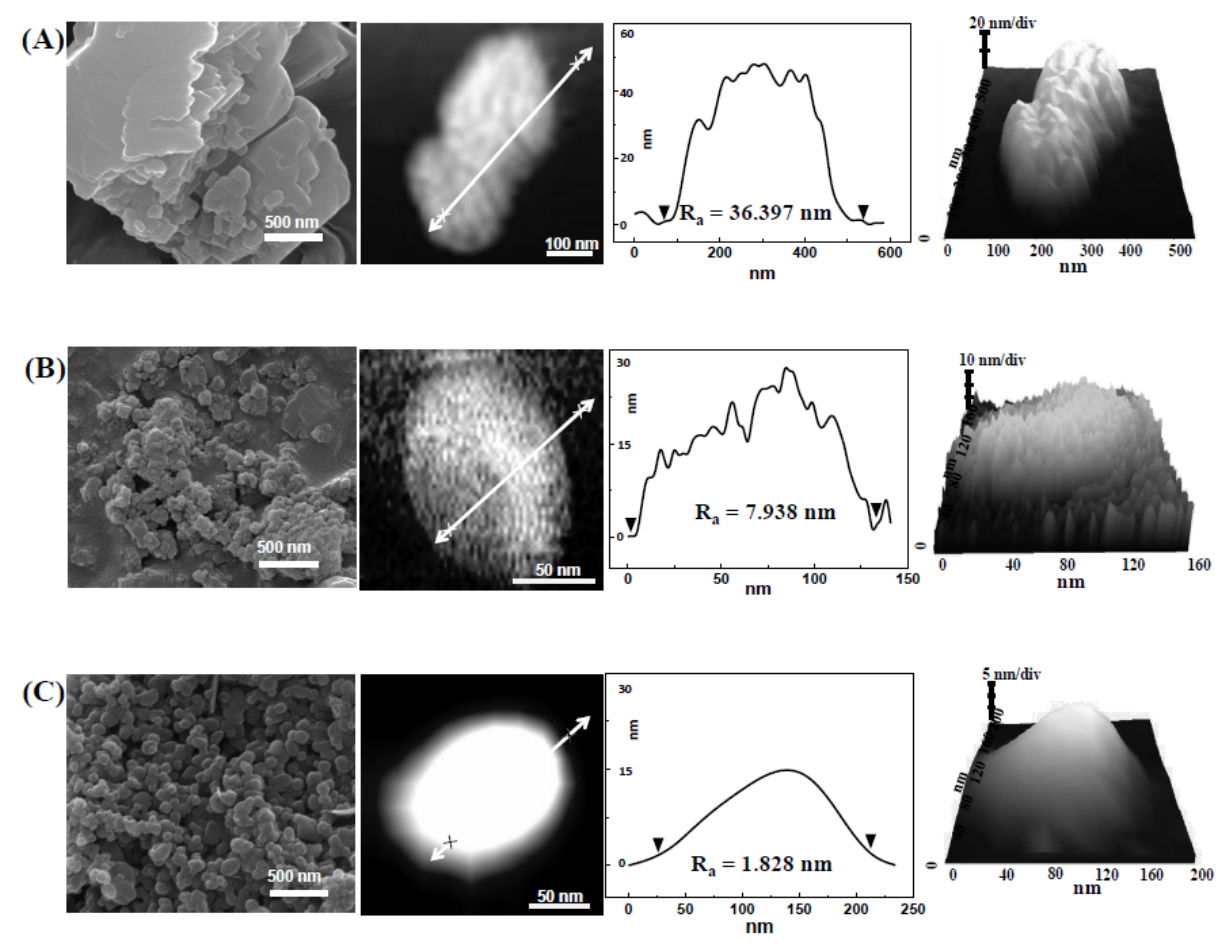
Figure 1. Scanning electron microscopy (SEM) images, atomic force microscope (AFM) images, height profiles, and 3D images of ( A ) food bulk CaCO 3 ; ( B ) food nano CaCO 3 ; and ( C ) SS CaCO 3